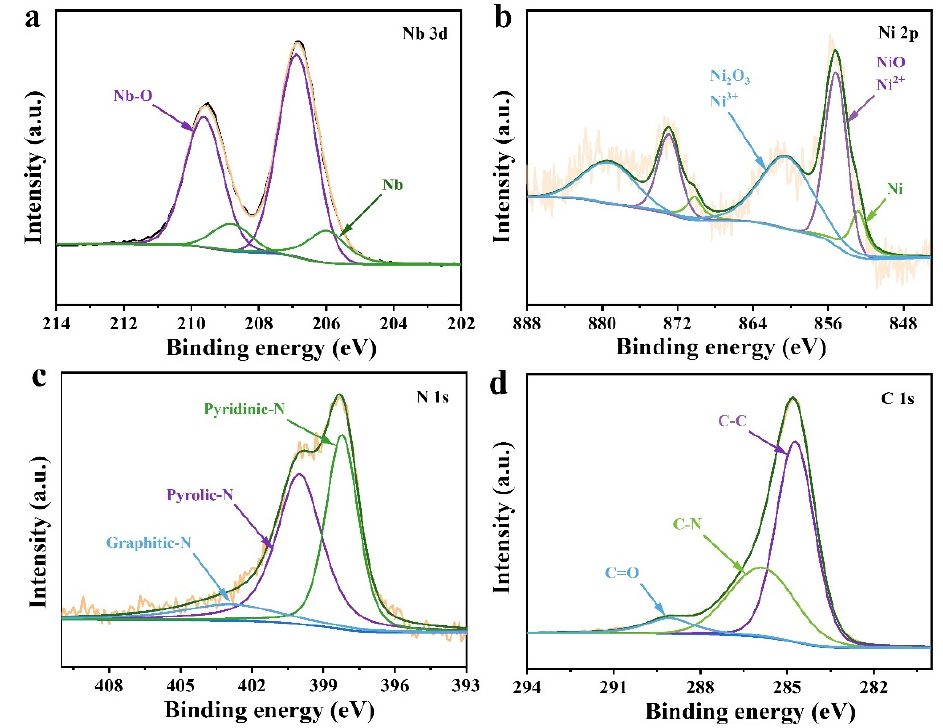
Figure 4. XPS spectra of Nb/Ni@NC nanofibers. High-resolution XPS spectra of: ( a ) Nb 3d; ( b ) Ni 2p; ( c ) N 1s; ( d ) C 1s. 2p; ( c ) N 1s; ( d ) C